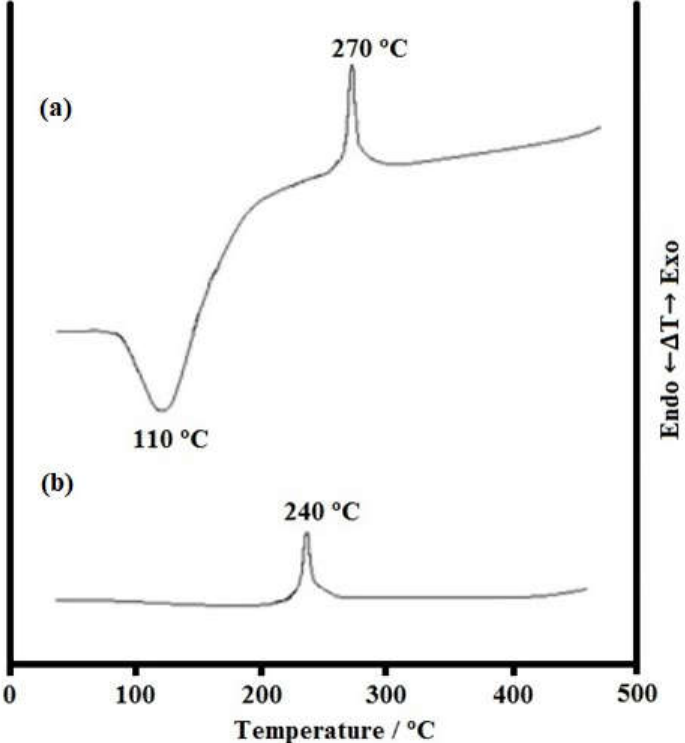
Figure 1. Differential thermal analysis results for (CeO 2 ) 0.90 (Sm 2 O 3 ) 0.10 xerogel prepared without ( a ) and with ( b ) xerogel freezing at −25 °C (24 h).